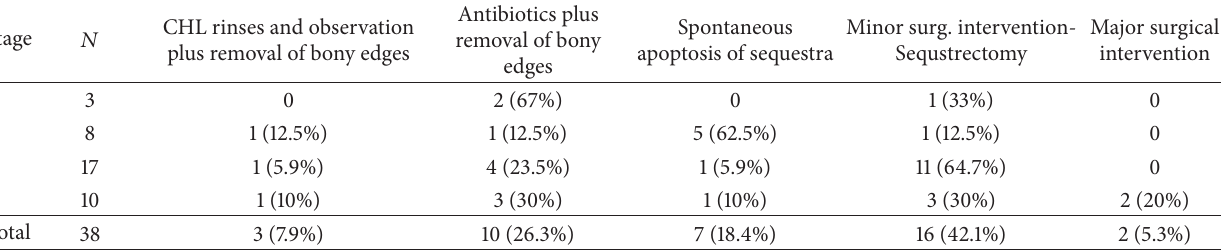
Table 2: Management of ONJ by stage.